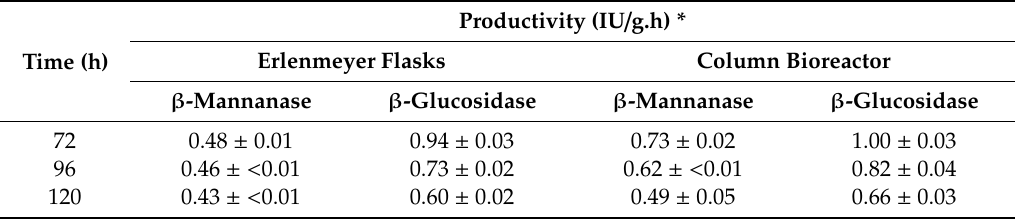
Table 2. Productivities of β -mannanase and β -glucosidase obtained in di ff erent types of cultures